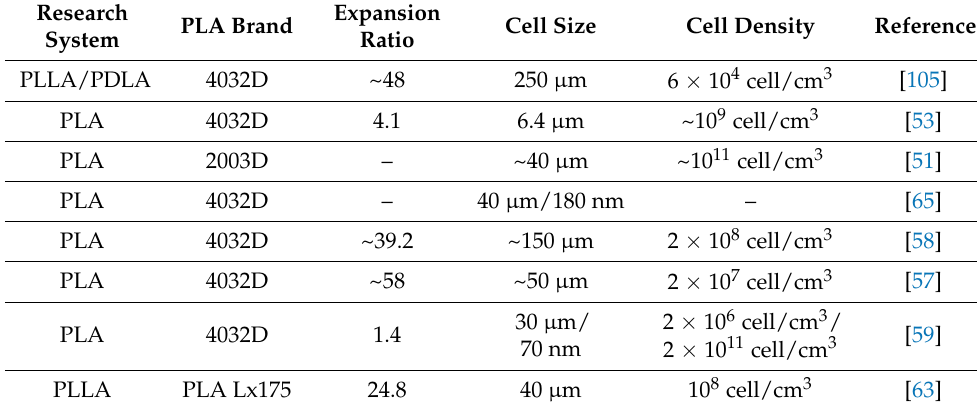
Table 5. Study on PLA foam by induced crystallization in the last three